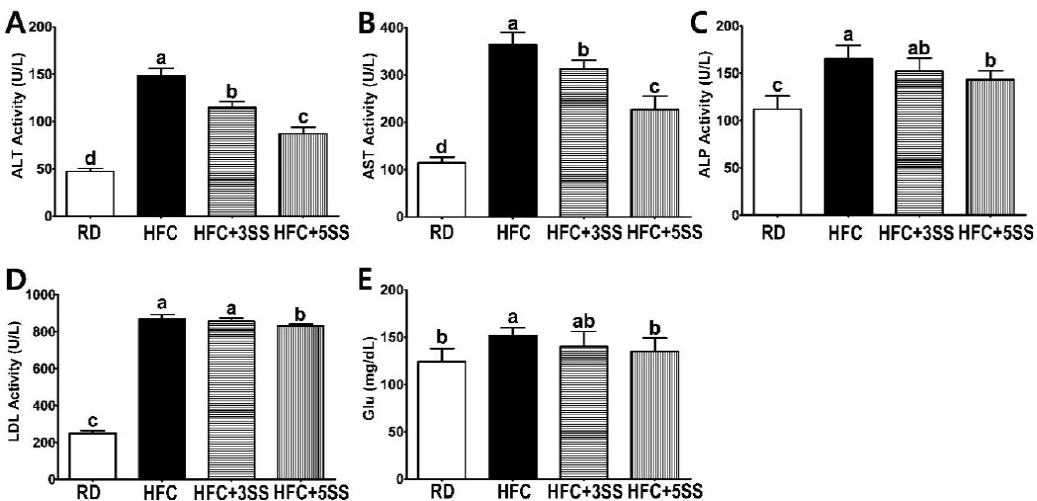
Figure 3. Effect of S. sieboldii Miq. root powder (SS) on hepatic function. Experimental rats were fed a regular diet (RD) or a high-fat and high-cholesterol (HFC) diet with or with-out Stachys sieboldii Miq. root powder (SS; 3 or 5%) supplementation for 6 weeks. ( A ) Alanine aminotransferase (ALT), ( B ) aspartate aminotransferase (AST), ( C ) alkaline phosphatase (ALP), ( D ) lactate dehydrogenase (LDH) and ( E ) fasting glucose (Glu) were analyzed enzymatically or biochemically. RD, regular diet; HFC, high-fat and high-cholesterol diet; HFC + 3SS, high-fat and high-cholesterol diet + 3% of Stachys sieboldii Miq. root powder; HFC + 5SS, high-fat and high-cholesterol diet + 5% of Stachys sieboldii Miq. root powder. Values are means ± standard deviation, n = 8. Data were analyzed by one-way ANOVA followed by Tukey’s post hoc test. Means labeled without a common letter differ significantly, p < 0.05.